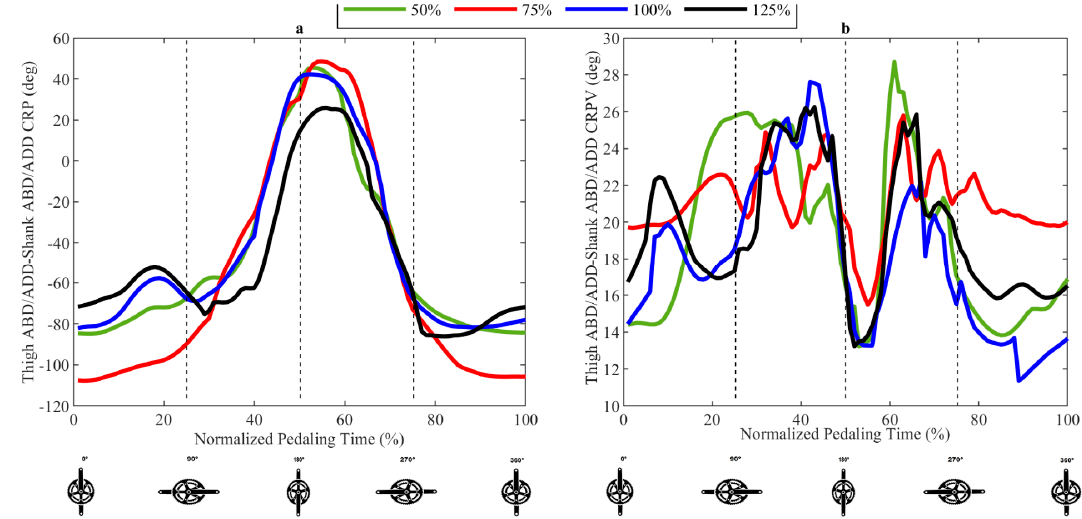
Figure 4. Thigh abduction/adduction (AD/AB)-Shank AD/AB continuous relative phase (CRP) ( a ) and continuous relative phase variability (CRPV) ( b ) in different pedaling intensities .